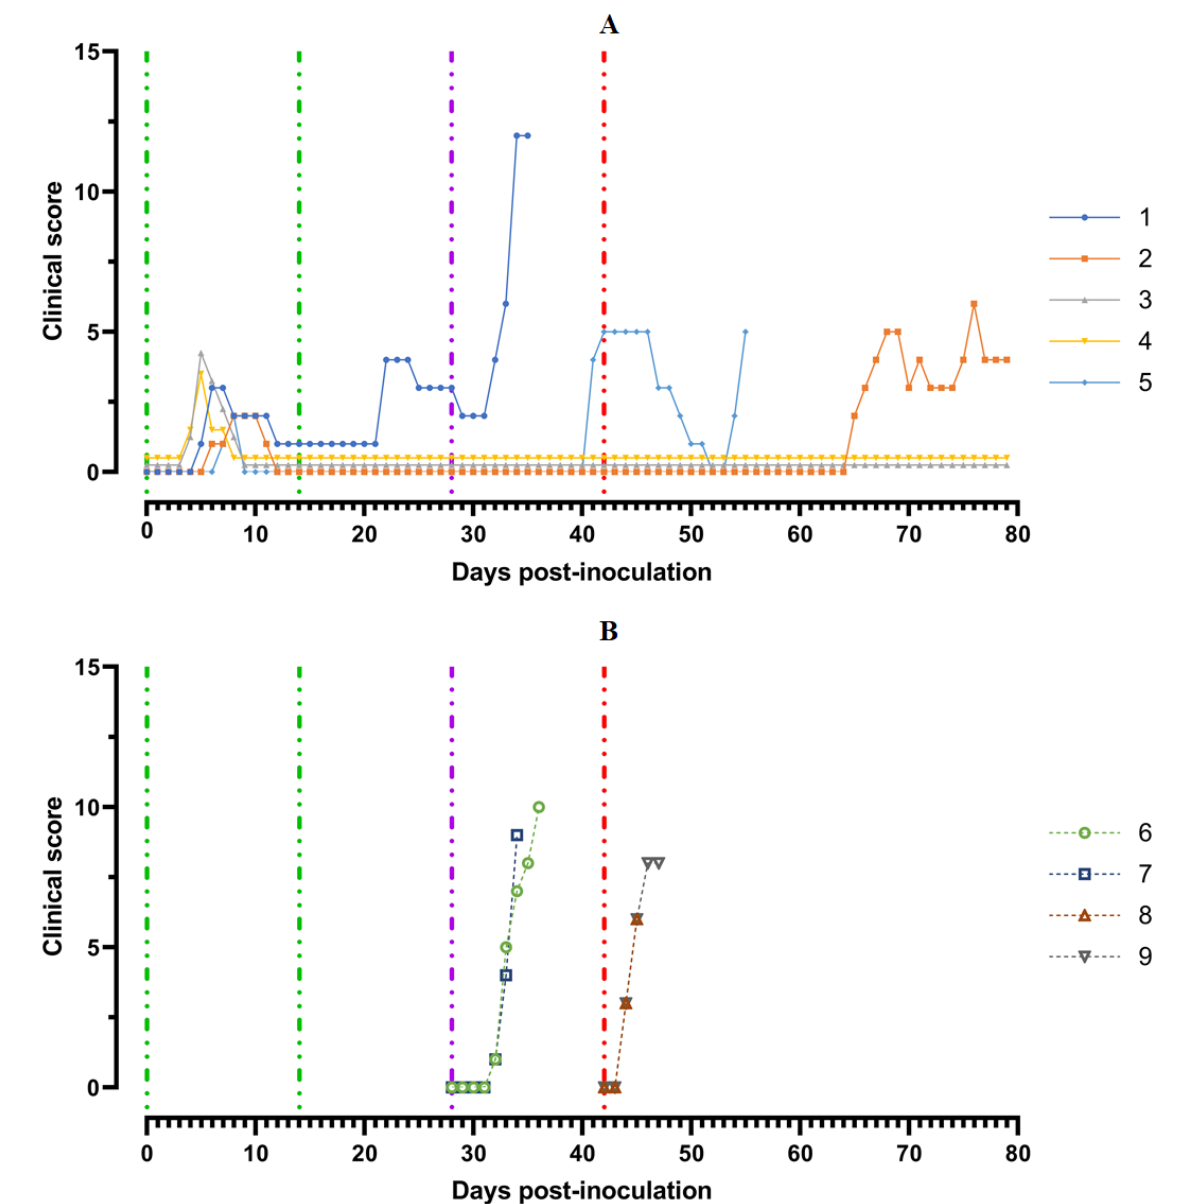
Figure 4. Clinical score of pigs: ( A ) group 1 (## 1–5) inoculated with 10 6.0 HAU 50 ASFV–Katanga-350 and challenged at a dose of 10 3.0 HAU 50 ASFV–Lisbon-57 and ASFV–Stavropol 08/01; ( B ) group 2 challenged with ASFV–Lisbon-57 (## 6, 7) and group 3 challenged with ASFV–Stavropol 08/01 (## 8, 9). Each curve represents an individual animal’s values. Vertical dashed lines: green—days of inoculation of ASFV–Katanga-350, purple—challenge by ASFV–Lisbon-57, red—infected by the ASFV–Stavropol 08/01 strain.